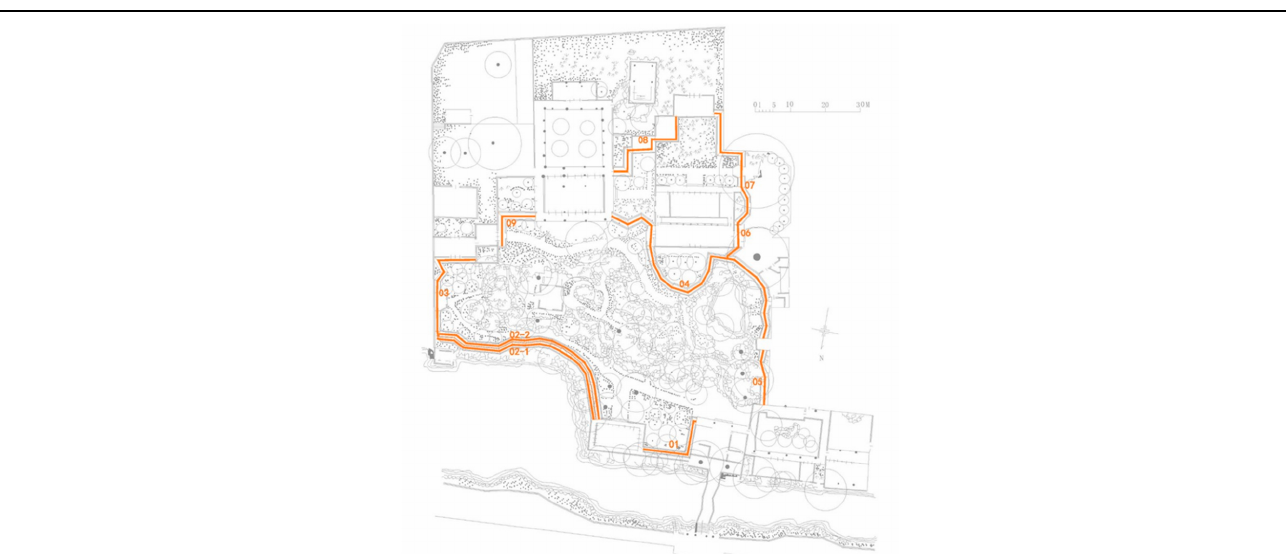
Table A13. Canglang Pavilion, corridor.